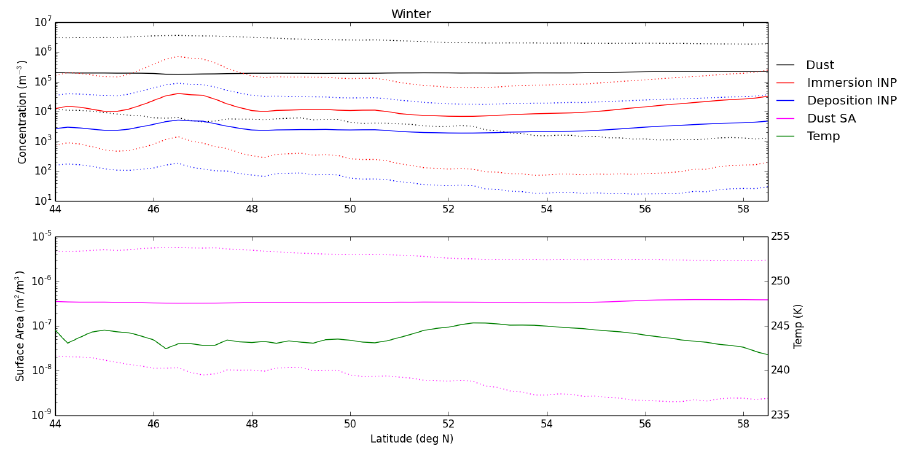
Figure 2. Top panel: median (solid), 5th and 95th percentiles (dotted) for total dust number concentration (black), potential immersion INP (red), and potential deposition INP at 110% (blue) at 6km above terrain over Europe for winter. Bottom panel: median (solid) and mean (dashed) total dust surface area (magenta) and temperature (green). Note that the Alpine regions are in a range about 46–48 ◦